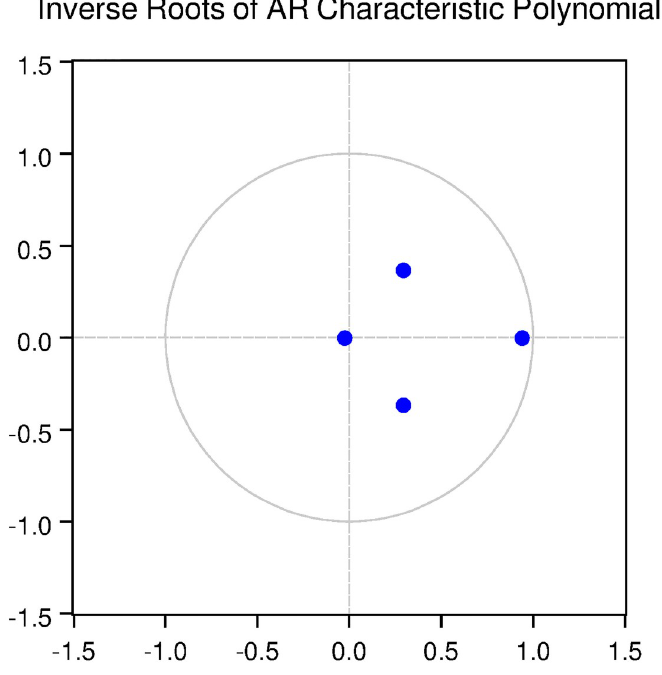
Fig 11. Inverse roots of AR characteristic polynomial for Japanese data when P = 2 (Fisherian model).